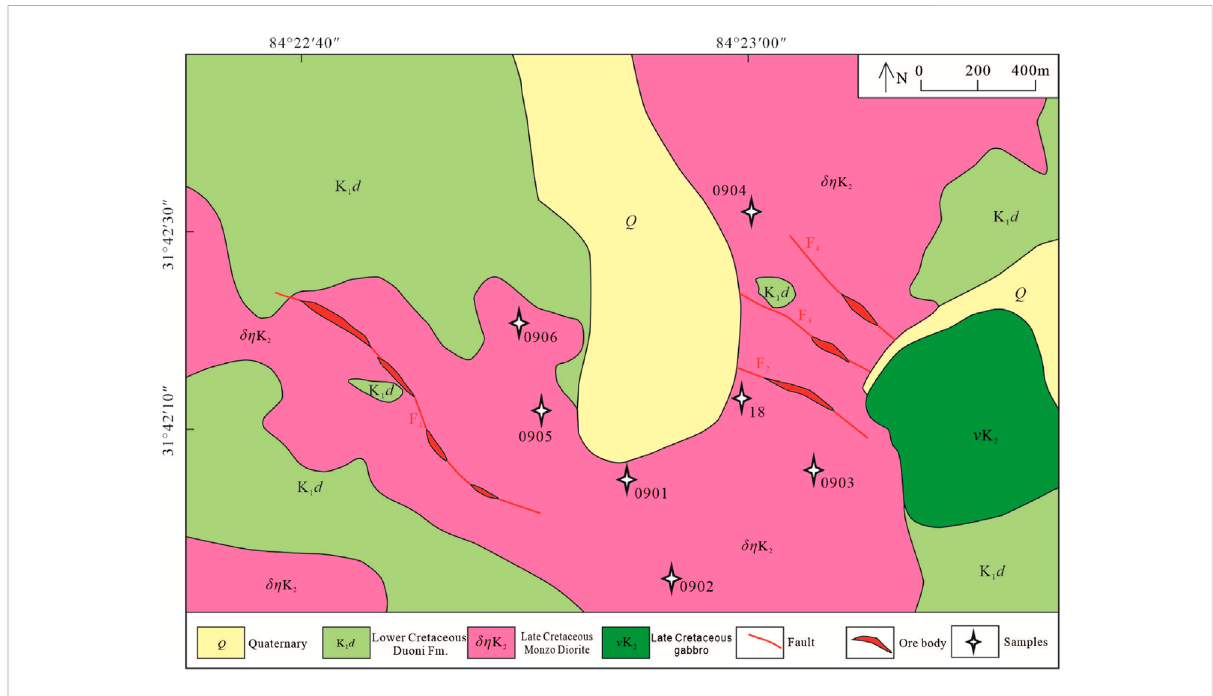
FIGURE 2 Geological map of the Budongla Gold